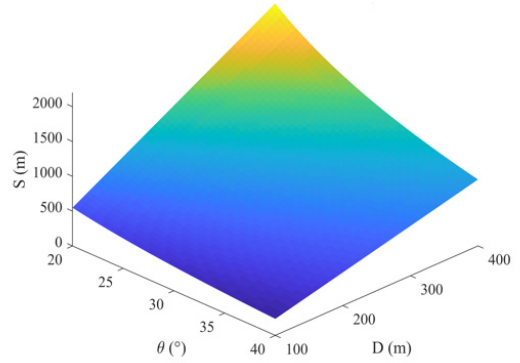
Figure 5. The relationship between the single-period horizontal distance and the profile depth and gliding angle.